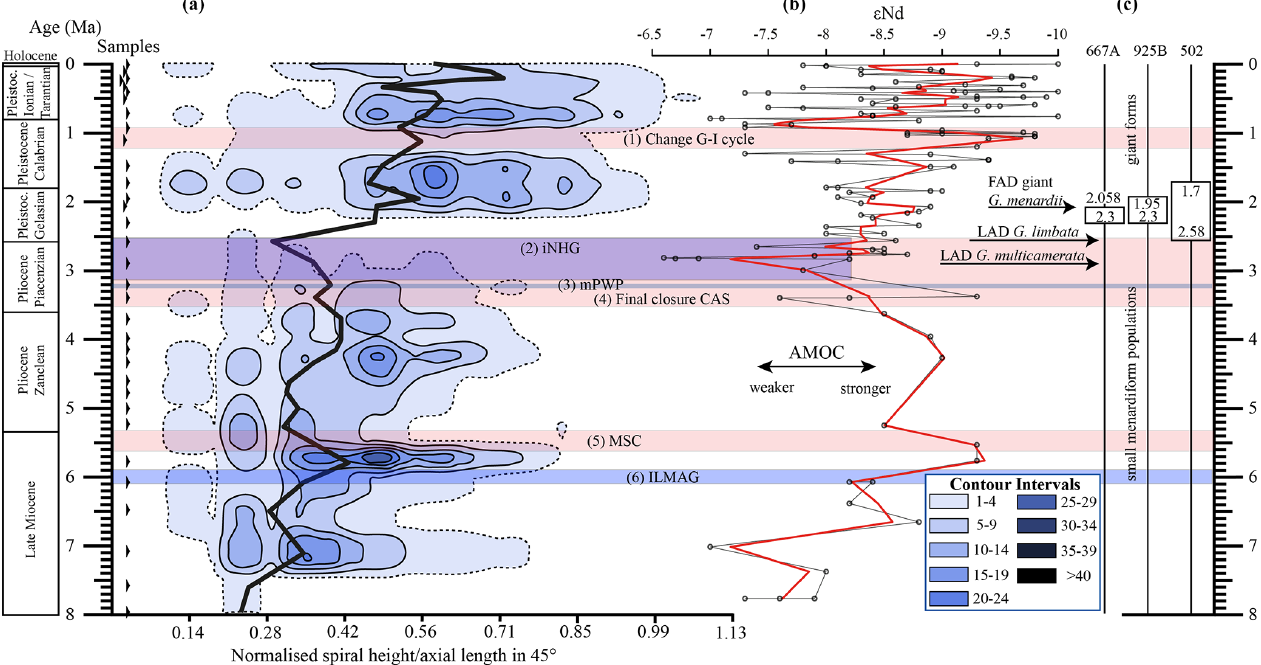
Figure A3. Frontal section (offset value =− 0.05, away from the reader) through the 45 ◦ view on VDD of Hole 667A in a palaeoceanographic context. The dotted line represents the interval line 1, and the solid lines show the contours with an interval of 5. The position of this section within the VDD is plotted in Fig. A2. For further explanation, see Fig. 10 in the